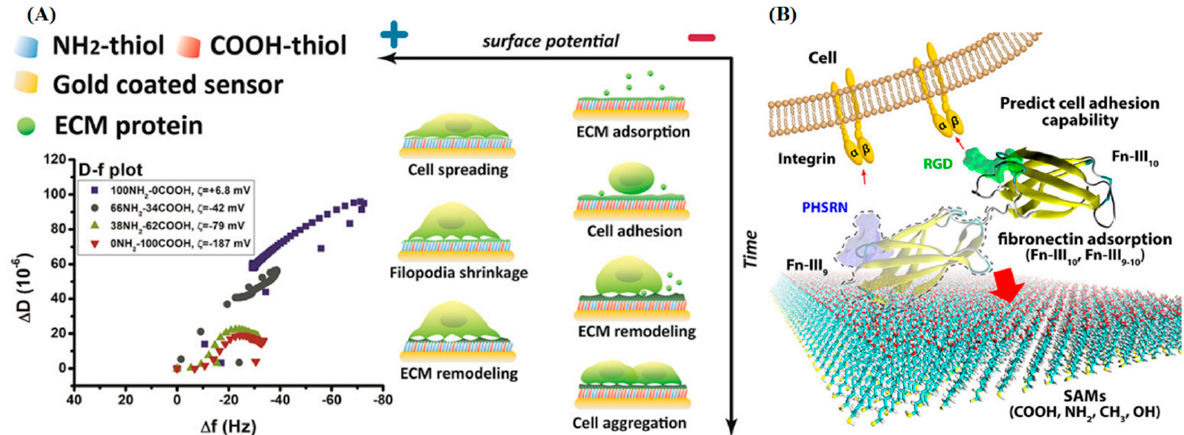
Figure 7. ( A ) The relationship between cell adhesion and ECM matrix surface charge. Reprinted with permission from [226]. Copyright 2017, American Chemical Society. ( B ) Role of the ninth type-III domain of fibronectin in the mediation of cell-binding domain adsorption on surfaces with different chemistries. Reprinted with permission from [227], Copyright 2018, American Chemical So- ciety.